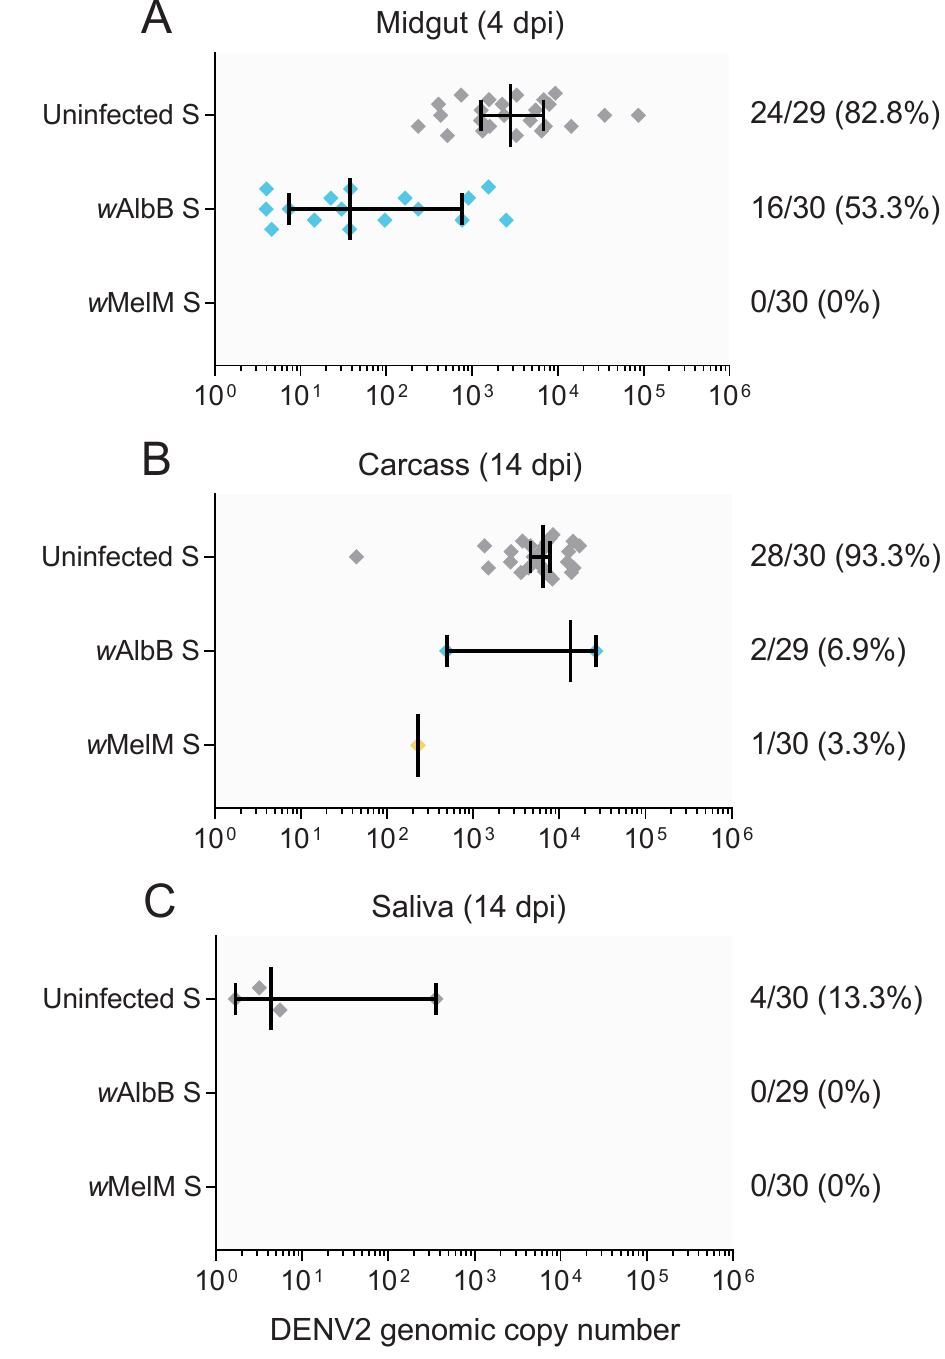
Fig 1. Comparison of DENV2 infection frequencies and copy numbers in uninfected, w AlbB-infected and w MelM-infected Ae . aegypti with a Saudi Arabian background. We fed females human blood spiked with DENV2 via membrane feeders. We then measured (A) midgut infection at 4 dpi, (B) dissemination to the carcass at 14 dpi and (C) saliva infection at 14 dpi as a proxy for transmission. Each symbol shows data from a single DENV2-positive sample (negative samples were excluded), while vertical lines and error bars represent medians and 95% confidence intervals. Numbers to the right of indicate the number of individuals positive for DENV2 out of the total number tested, followed by the percent